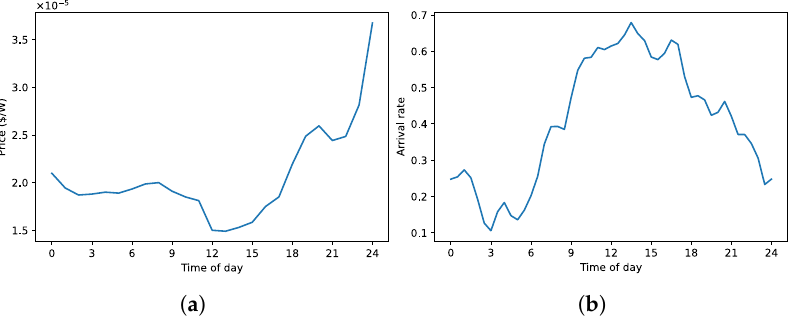
Figure 5. ( a ) An example of the power price curve for a single day. ( b ) Poisson process rate used to model the EV arrivals.